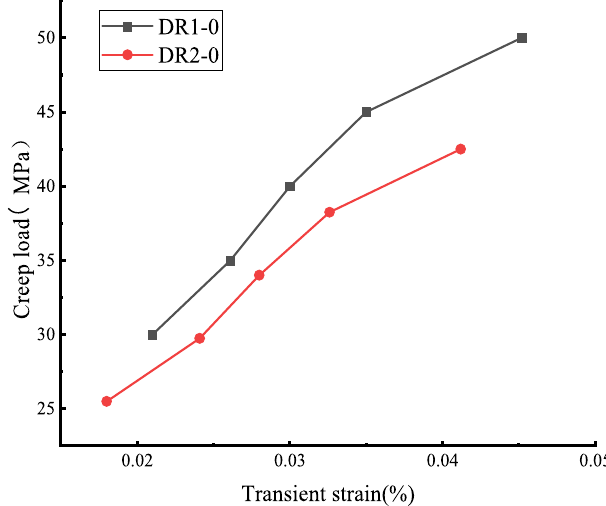
Figure 9. Relationship between instantaneous axial strain and creep loading.